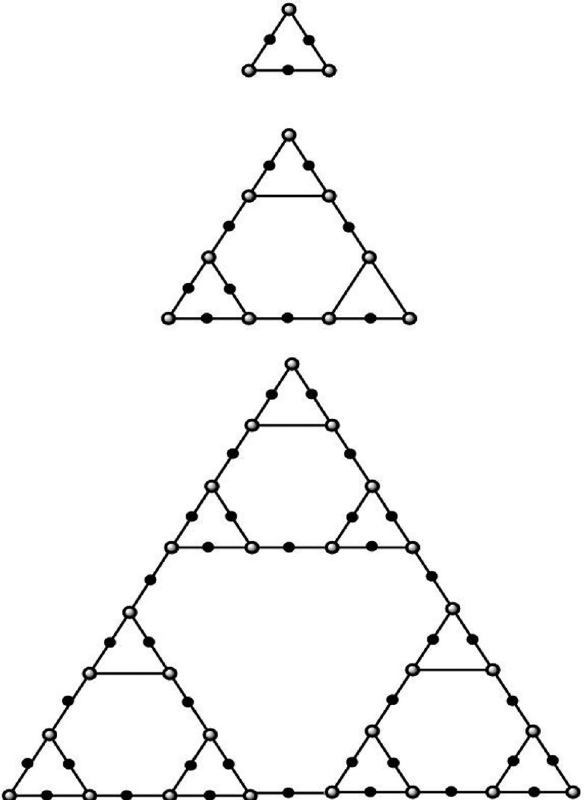
Figure 2: The generalized Sierpiński graphs for the SD ( S( 1,C